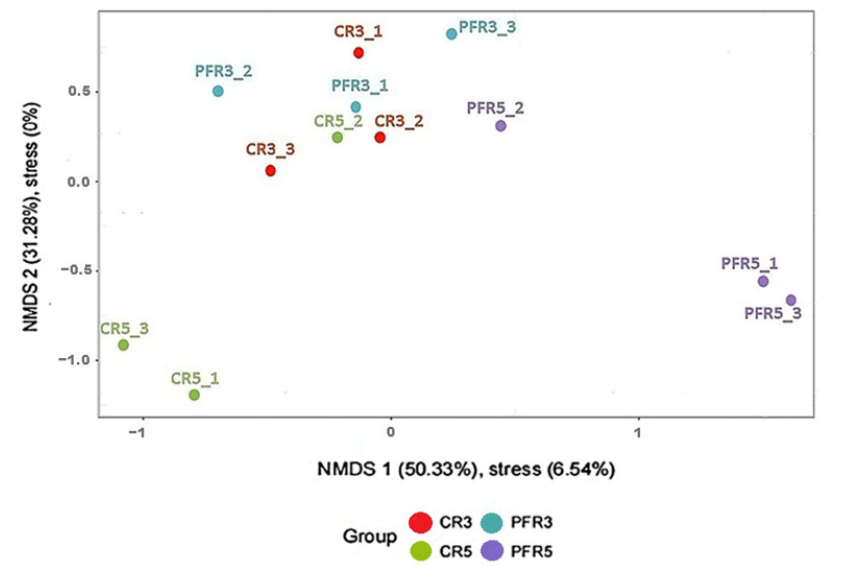
Figure 6. Non-metric multidimensional scale (NMDS) plots corresponding to the clustering of fungal communities in different habitats, i.e., calyx-end tissue from unbagged fruit: CR3 (red); calyx-end tissue from bagged fruit: CR5 (green); peel tissue from unbagged fruit: PFR3 (blue); peel tissue from bagged fruit: PFR5 (purple). Cluster analysis was performed using the Bray–Curtis coefficient- based community similarity measure. In the plot, the x -axis and y -axis represent the 1st and 2nd principal coordinates, respectively. The percentage of the principal coordinates represents the relative contribution of the coordinate to the sample differences. A closer distance represents higher similarity, and samples that cluster together consist of similar microbiota.